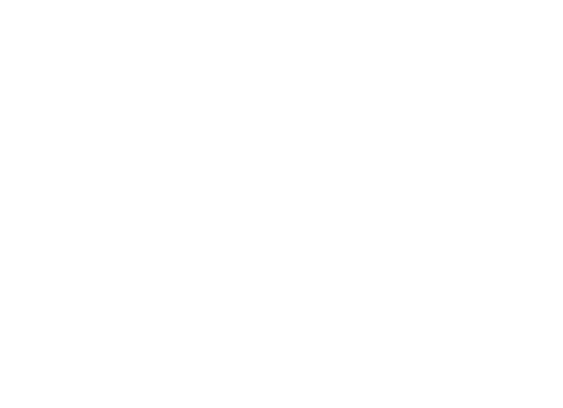
Frontiers in Aging Neuroscience |